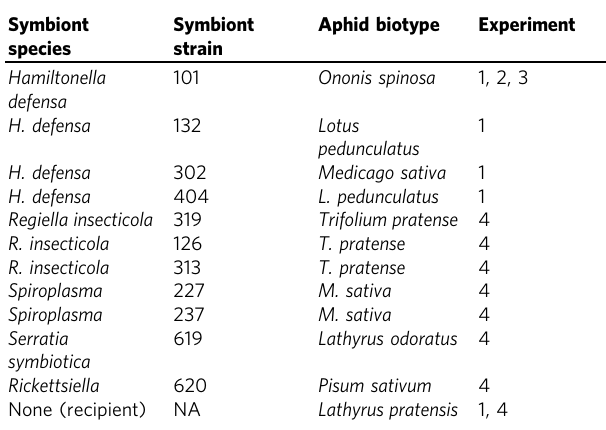
Table 1 Symbiont strains used, and the aphid Acyrthosiphon pisum biotype from which they were eliminated with antibiotics, or obtained when